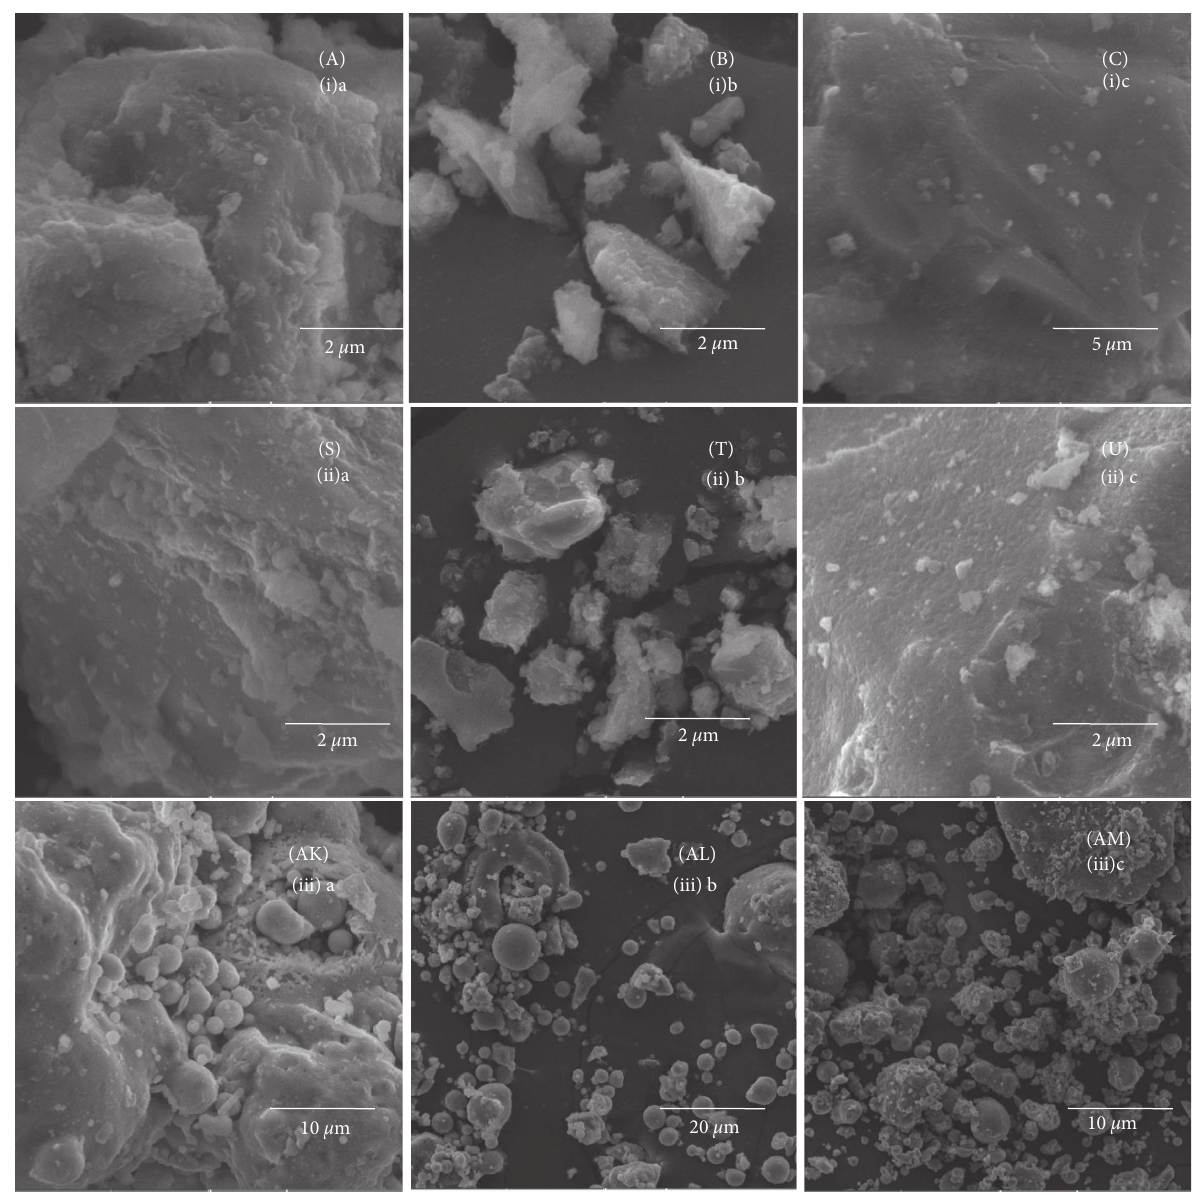
Figure 3: SEM images of geopolymer paste with 2.5M of